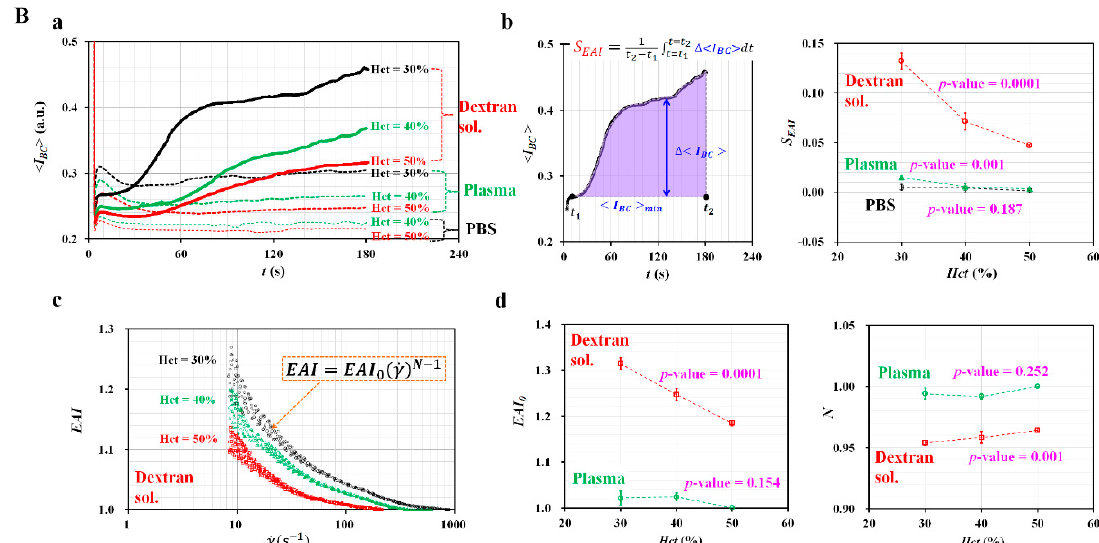
Figure 4. Quantitative evaluation of the effect of hematocrit and base solution on pressure and RBC aggregation. ( A ) Variations of pressure ( PI ) with respect to hematocrit ( Hct ) ( Hct = 30%, 40%, and 50%) and base solution (PBS, plasma, and dextran solution (10 mg/mL)). ( a ) Temporal variations of Δ <I PC > with respect to hematocrit and base solution. ( b ) Variations of PI with respect to hematocrit and base solution. ( B ) Variations of RBC aggregation ( EAI ) with respect to hematocrit and base solution. ( a ) Temporal variations of < I BC > with respect to hematocrit and base solution. ( b ) Variations of S EAI with respect to hematocrit and base solution. ( c ) Variations of EAI with respect to shear rate ( ( d ) Variations of EAI 0 and N with respect to hematocrit and base